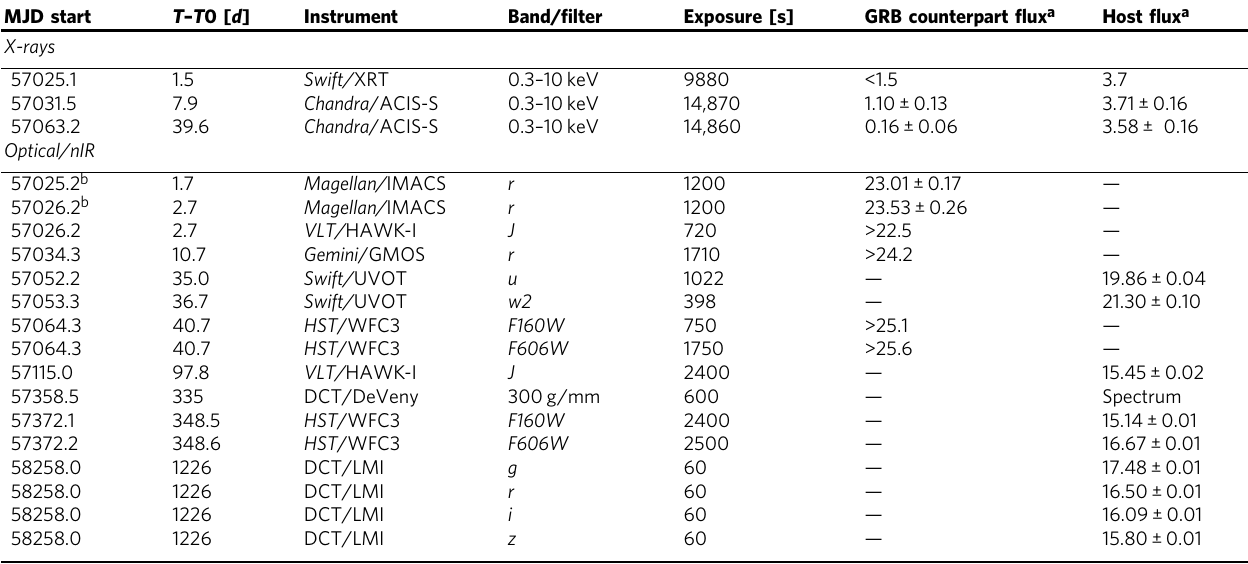
Table 2 Observations of GRB150101B. Upper limits are 3 σ MJD start